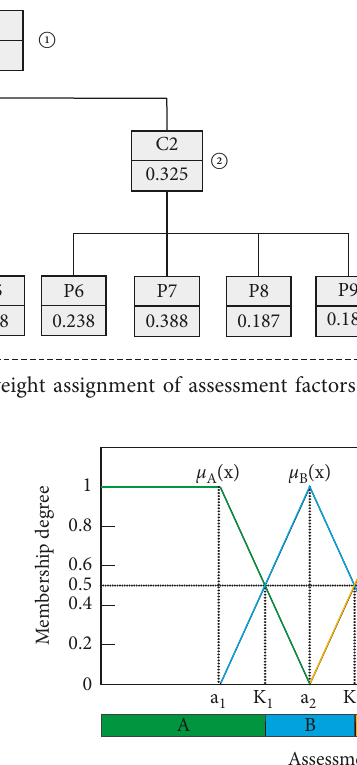
Figure 3: Membership function of the health grades.